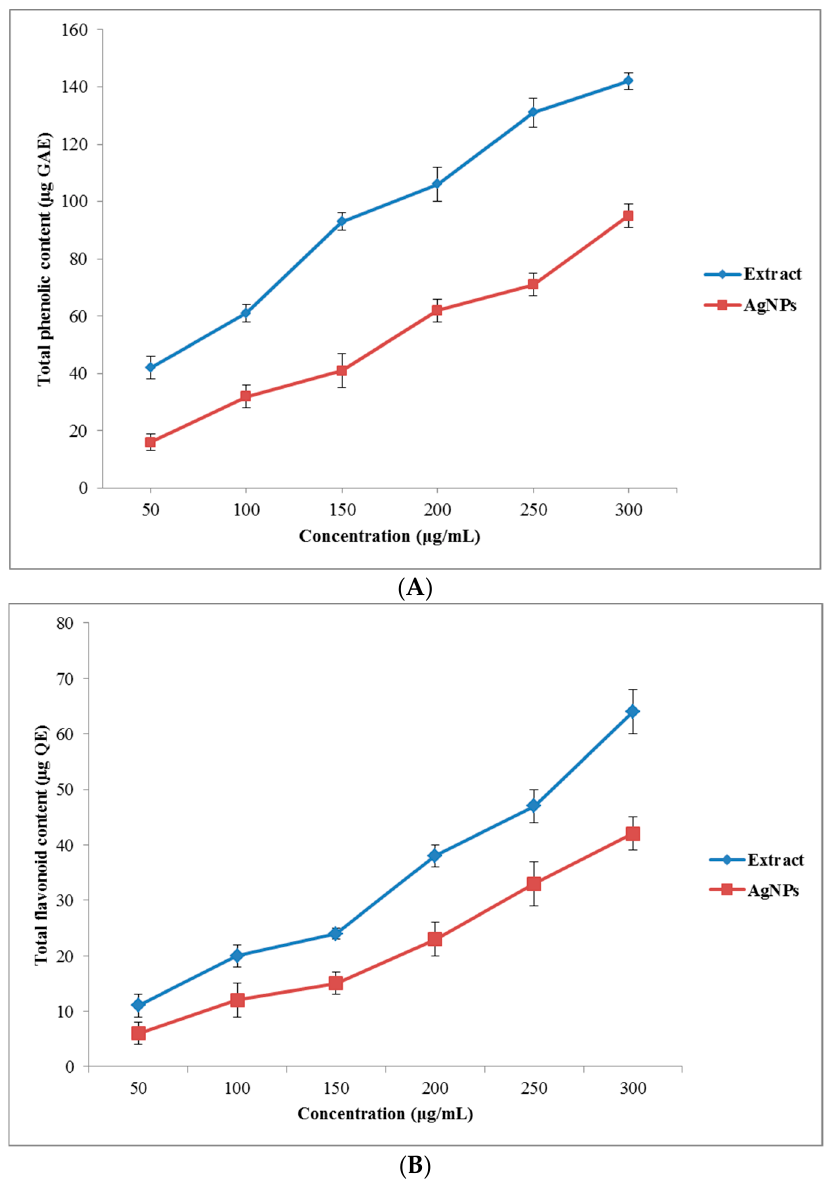
Figure 5. ( A ) The total phenolics and ( B ) the total flavonoids content of the O. persica leaf extract and the phytofabricated